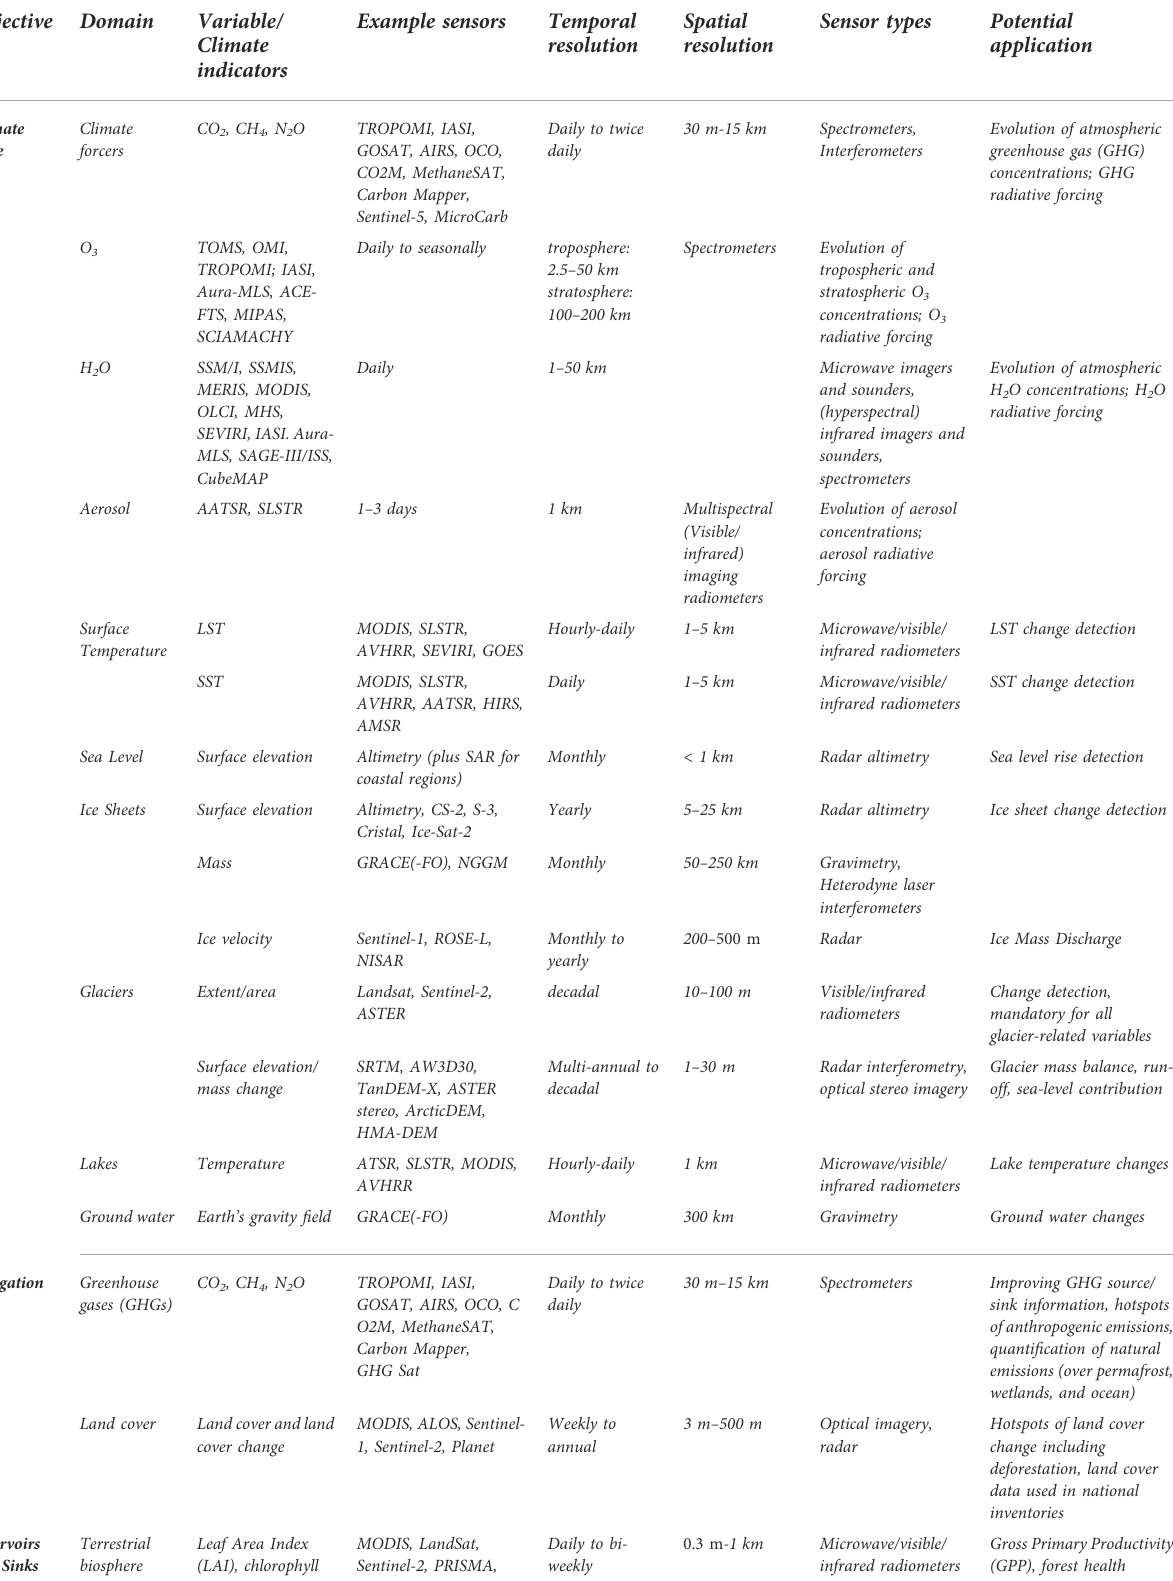
TABLE 1 Example list of Essential Climate Variables from various types of current and future sensors and their key characteristics, along with suggested applications for each of the Paris Agreement ’ s objectives.